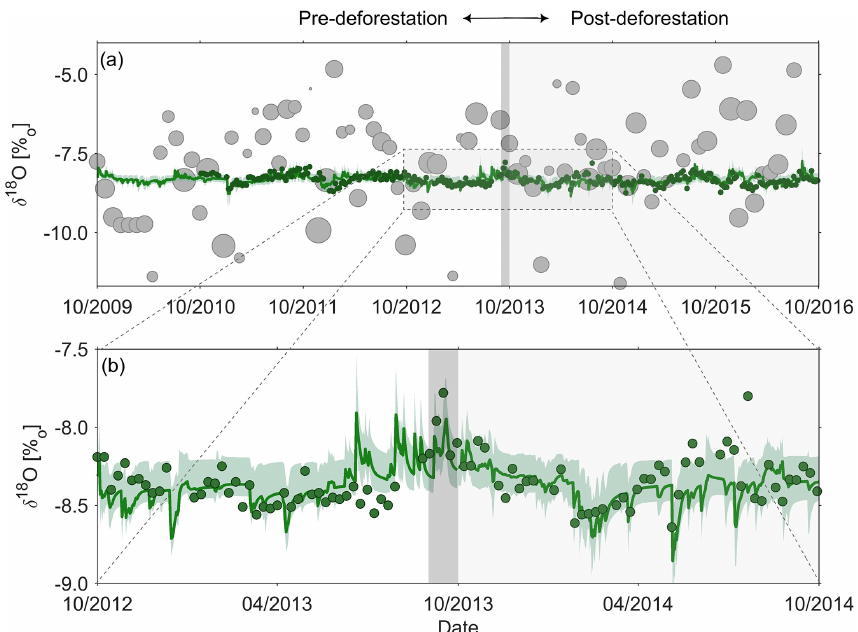
Figure 3. (a) Observed volume-weighted monthly δ 18 O signals in precipitation (grey dots; size of dots indicates the precipitation volume) and streamflow (green dots) as well as the best fit modelled δ 18 O signal in the stream (green line) and the 5th / 95th percentile of all feasible solutions from pre- and post-deforestation calibration (green shaded area); (b) zoom-in of observed and modelled δ 18 O signals in the stream for the October 2012–October 2014